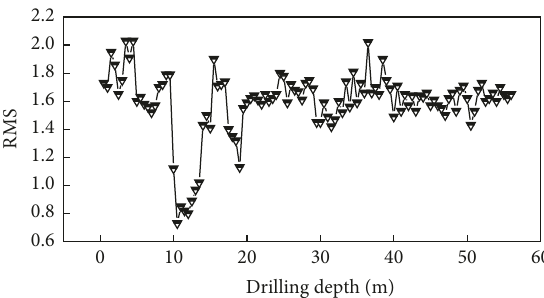
Figure 15: Distribution of RMS values for in-seam boreholes.